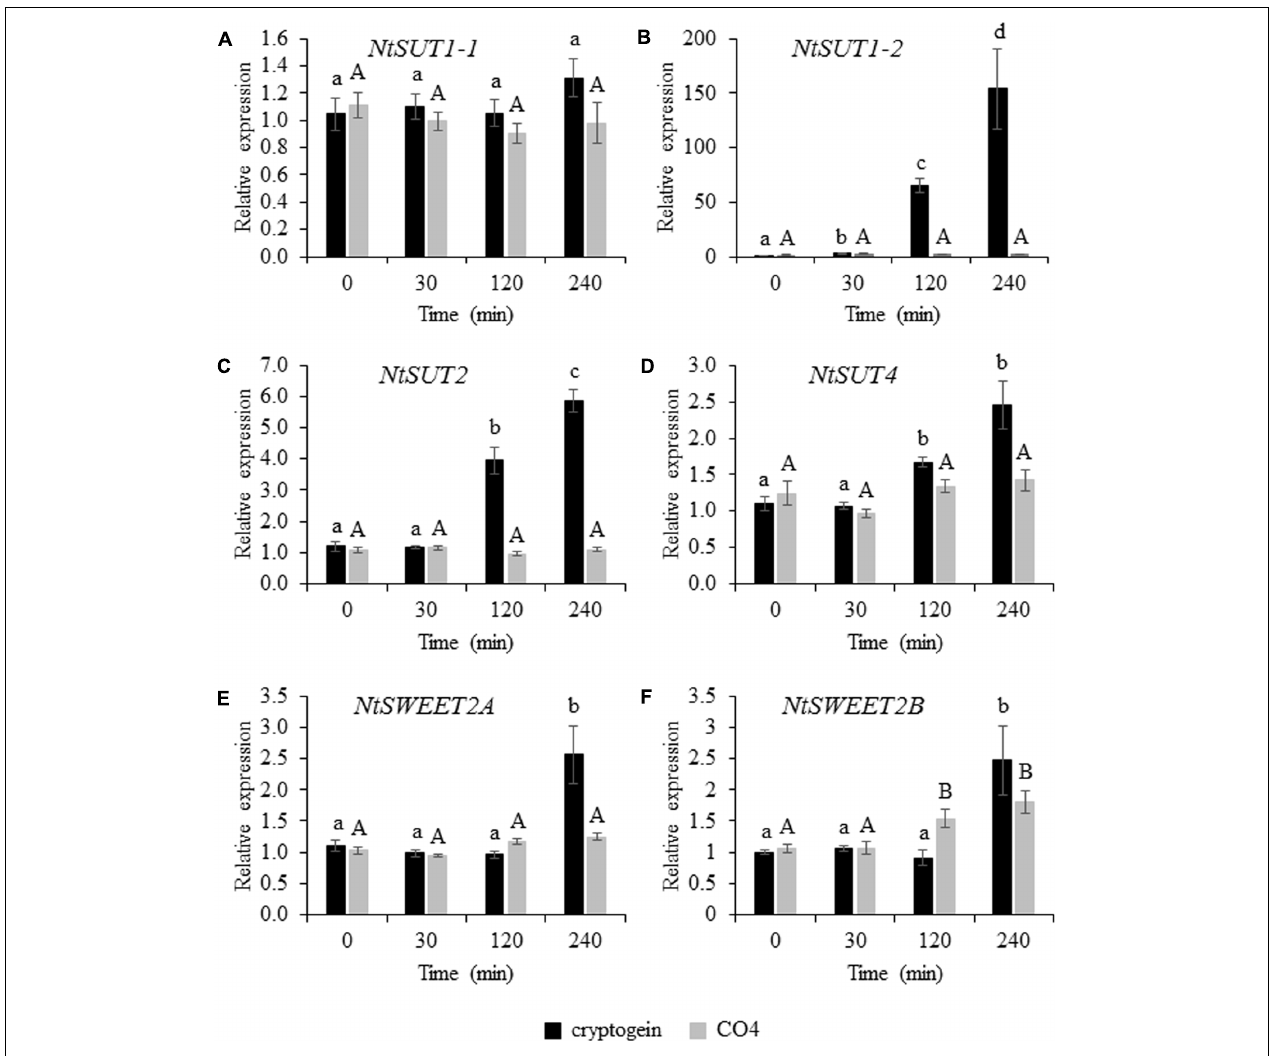
FIGURE 5 | Transcript level of NtSUTs and NtSWEETs in tobacco cells 0, 30, 120, and 240 min after cryptogein or CO4 treatment. Relative expression of NtSUT1-1 (A) , NtSUT1-2 (B) , NtSUT2 (C) and NtSUT4 (D) , NtSWEET2A (E) and NtSWEET2B (F) . Transcript levels were measured in tobacco cells treated with 50 nM cryptogein (black bars) or 100 nM CO4 (gray bars). NtEF1 α and NtL25 were used as housekeeping genes, and expression data were further normalized to untreated cells for each time point measurement. These data represent the means ± SEs of three independent experiments. Statistical analysis was carried out using ANOVA followed by Tukey’s test ( p < 0.05). Capital or lower-case letters correspond to statistical groups following CO4 or cryptogein treatment,